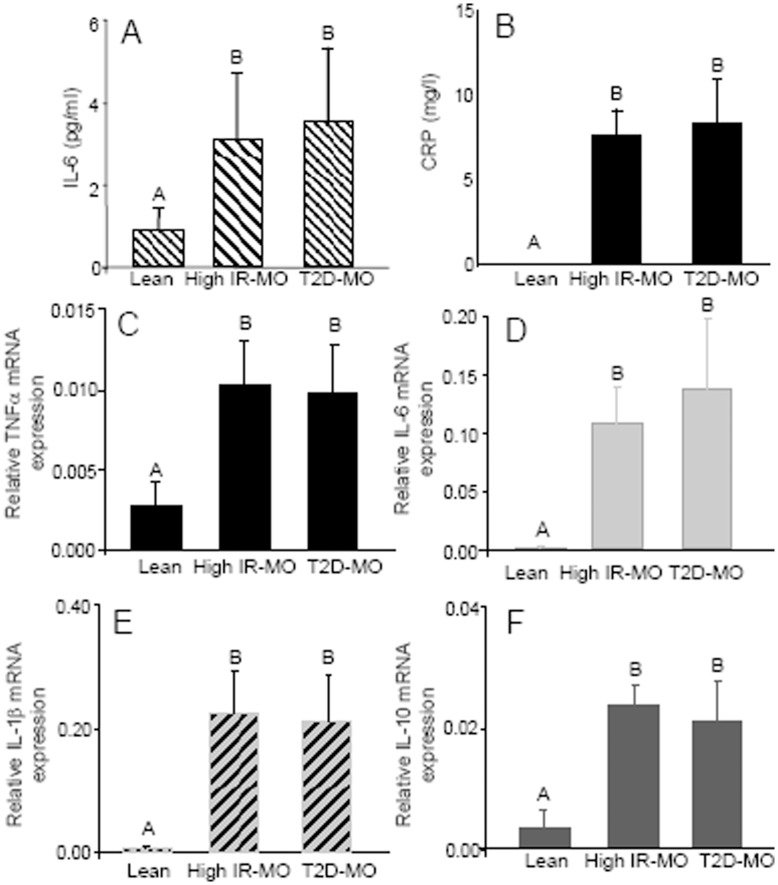
Increased levels of proinflammatory cytokines in serum and visceral adipose tissue from high IR-MO and T2D-MO subjects.(A and B) IL-6 and CRP plasma levels were increased in blood from the morbidly obese group compared with the undetectable amounts observed in healthy lean controls (p<0.01). There were not significant differences in the levels of these markers between high insulin resistance and diabetic groups. (C, D, E and F) There was a great increase of proinflammatory cytokines mRNA expression (TNFα, IL-1β, IL-6 and IL-10) in VAT of MO patients compared with controls (p<0.01). Of note, elevated levels of TNFα, IL-1β, IL-6 and IL-10 mRNA in MO with high insulin resistance degree were not statistically different from the levels found in T2D-MO. Significant differences (Duncan; p<0.05) are indicated with different words.